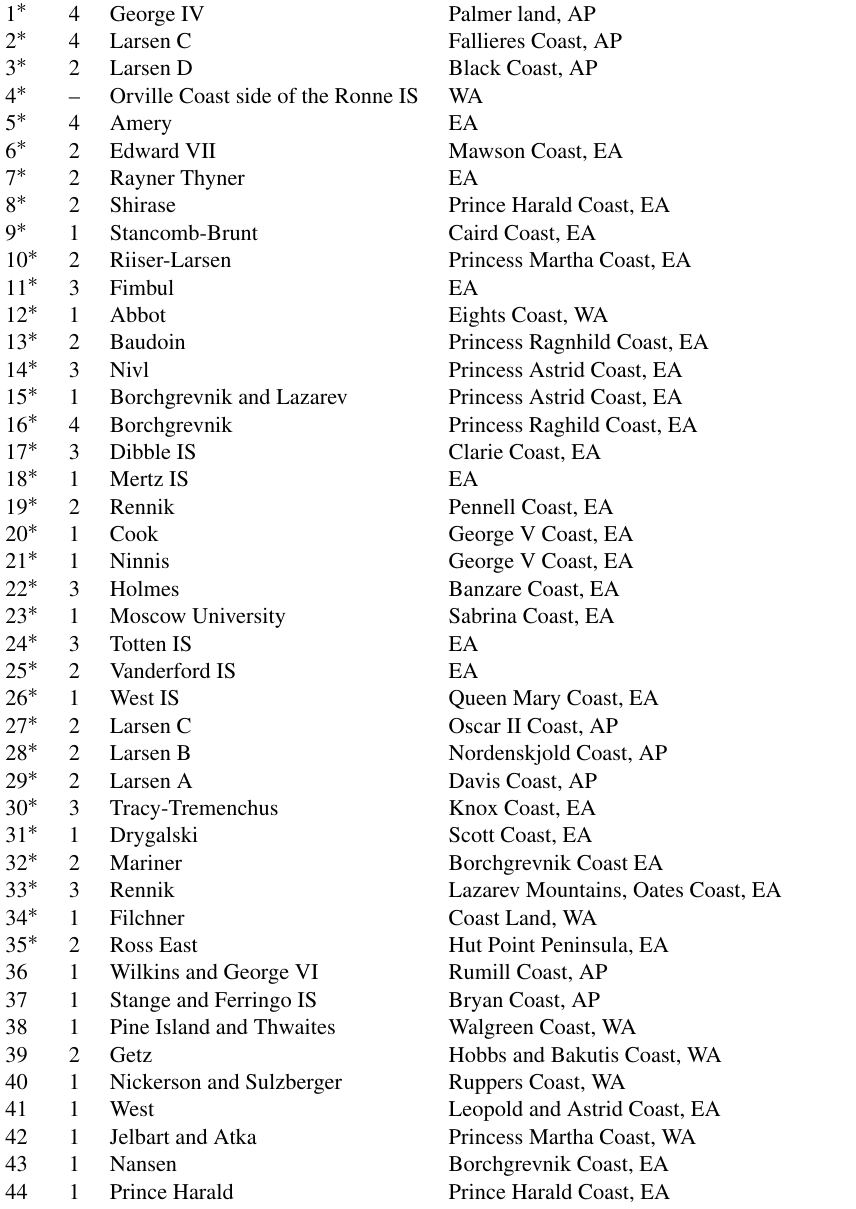
Table 6. A list of analysed ice shelf regions. Fracture observations for the model calibration process were taken from regions marked with ∗ . 1